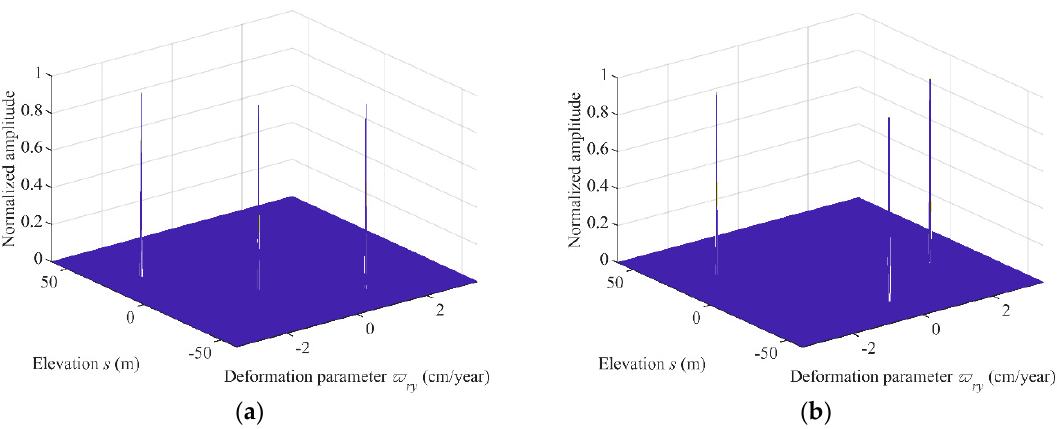
Figure 5. Estimation of elevation and deformation parameters of two stacks of combined acquisitions.